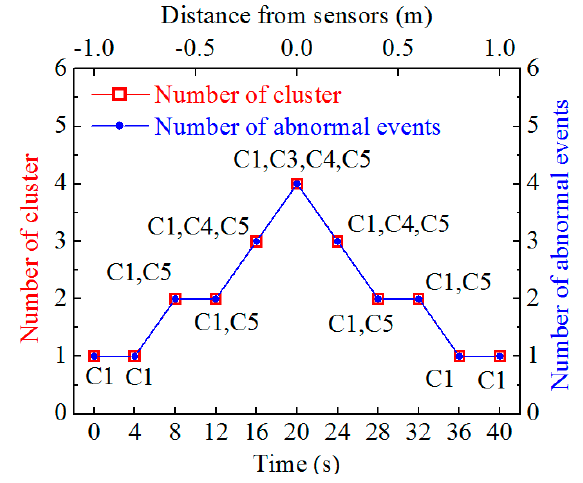
Figure 8. Time response of AP-DBSCAN on Spark Streaming.